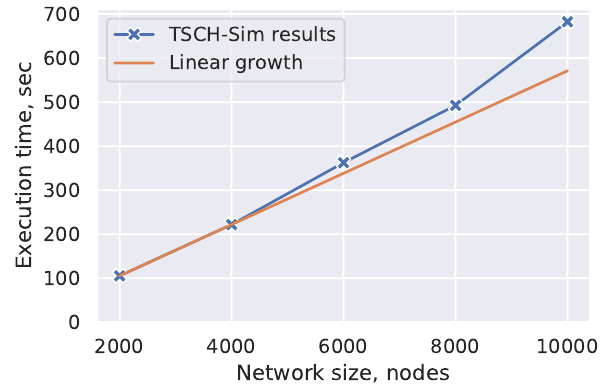
Figure 10. Simulation speed of 1h long simulations in hierarchical